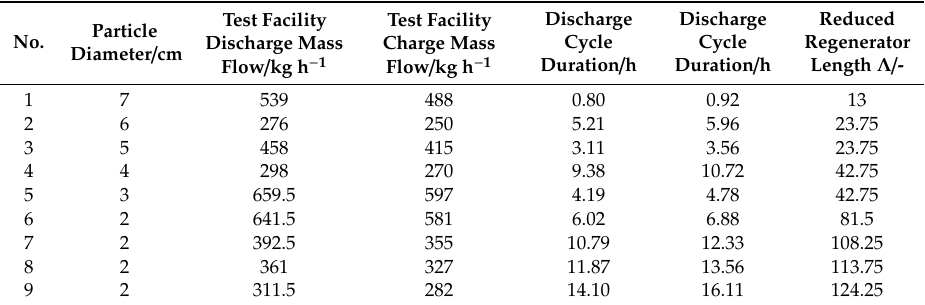
Figure 4. With HOTREG reproducible values for the dimensionless regenerator parameters. Table 3. Results for thermal equivalent HOTREG trails.